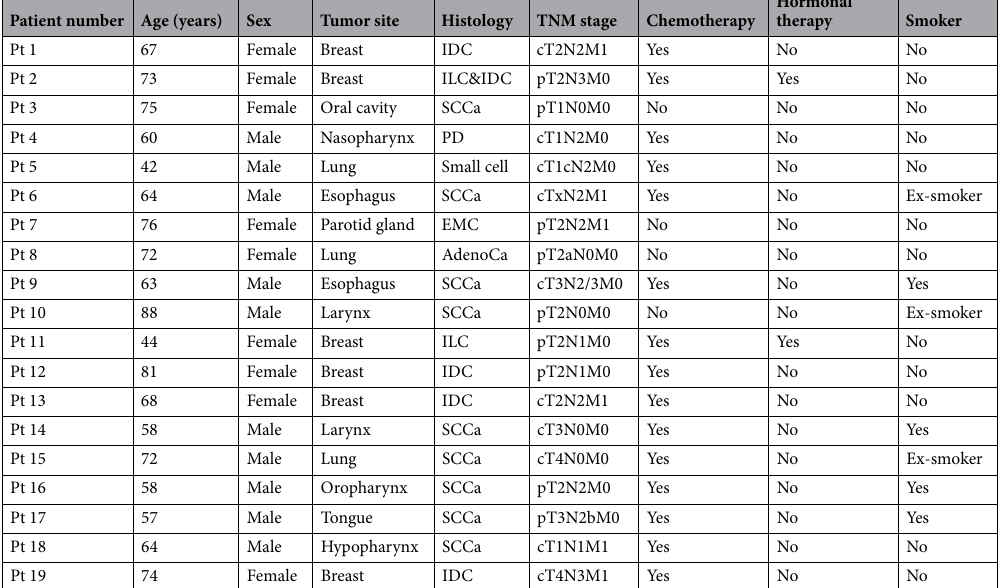
Table 1. Patient characteristics. IDC Invasive ductal carcinoma, ILC invasive lobular carcinoma, SCCa squamous cell carcinoma, PD poorly differentiated, EMC epithelial myoepithelial carcinoma, AdenoCa